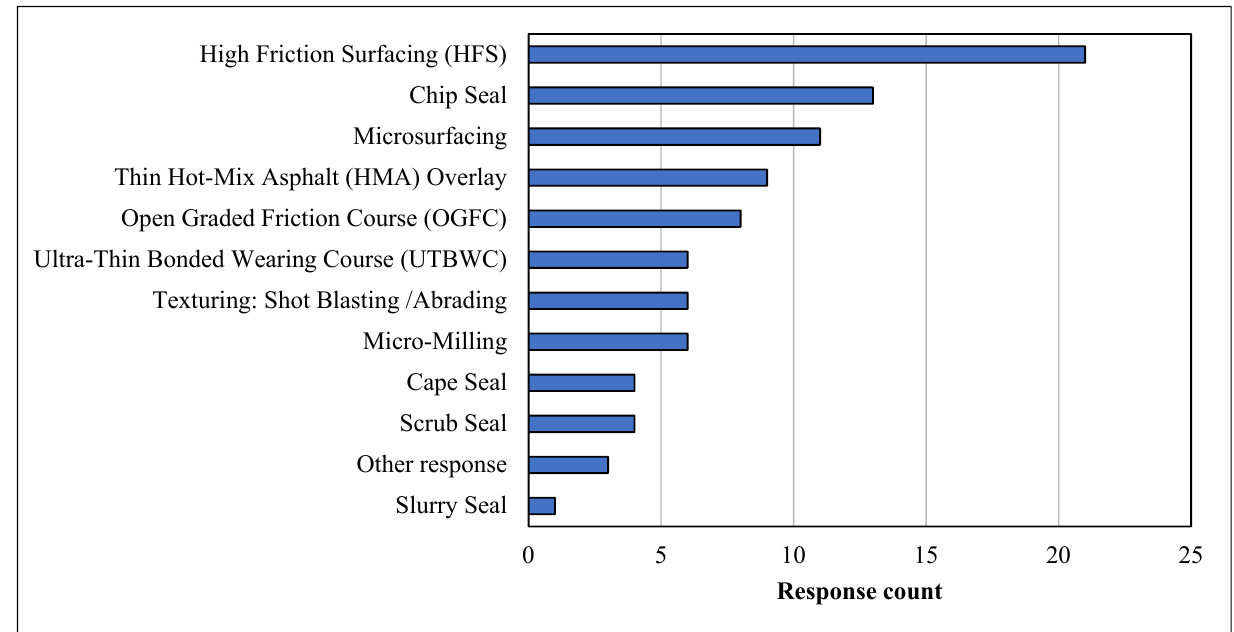
Figure 7. Types of pavement friction treatments considered for asphalt pavement.